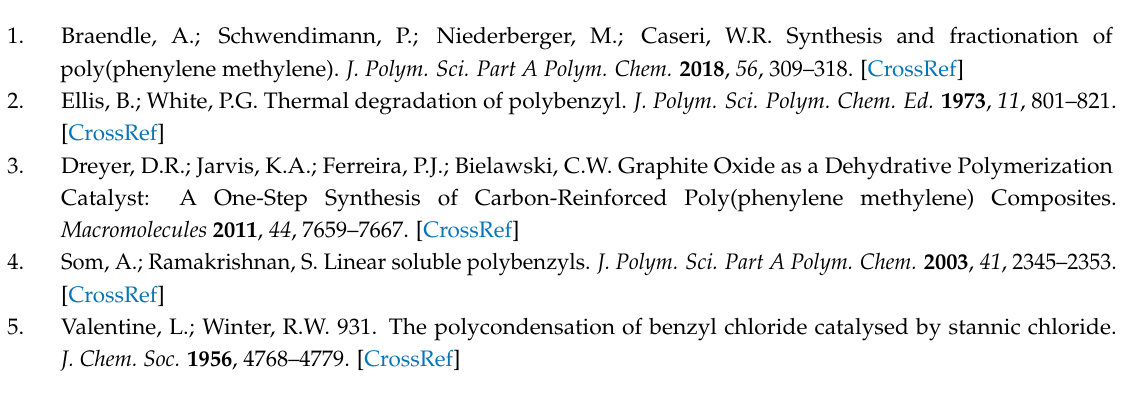
Table S1: Temperature, amount, and conversion at the time of the removal of the aliquots; Figure S1: 1 H NMR spectra of all aliquots resolved by